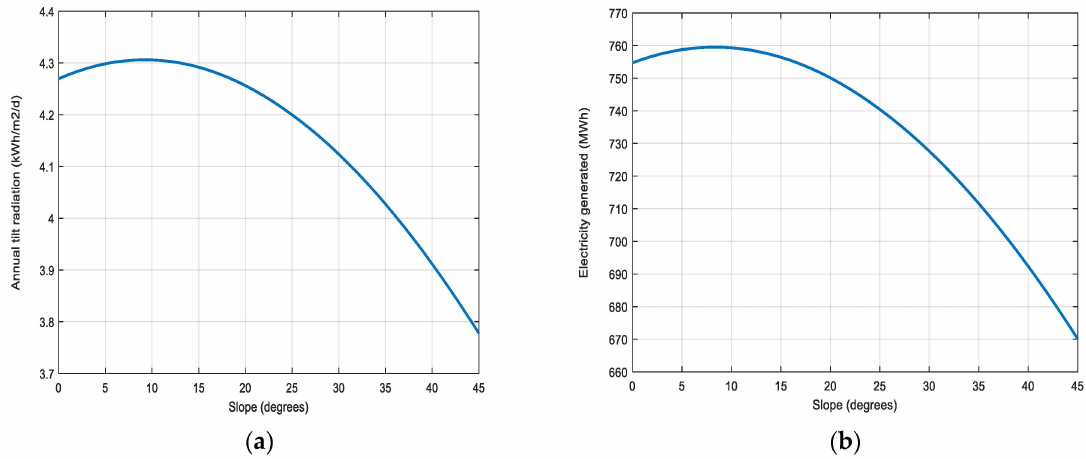
Figure 6. Okorobo-Ile town optimal: ( a ) PV orientation; ( b ) electricity generation.